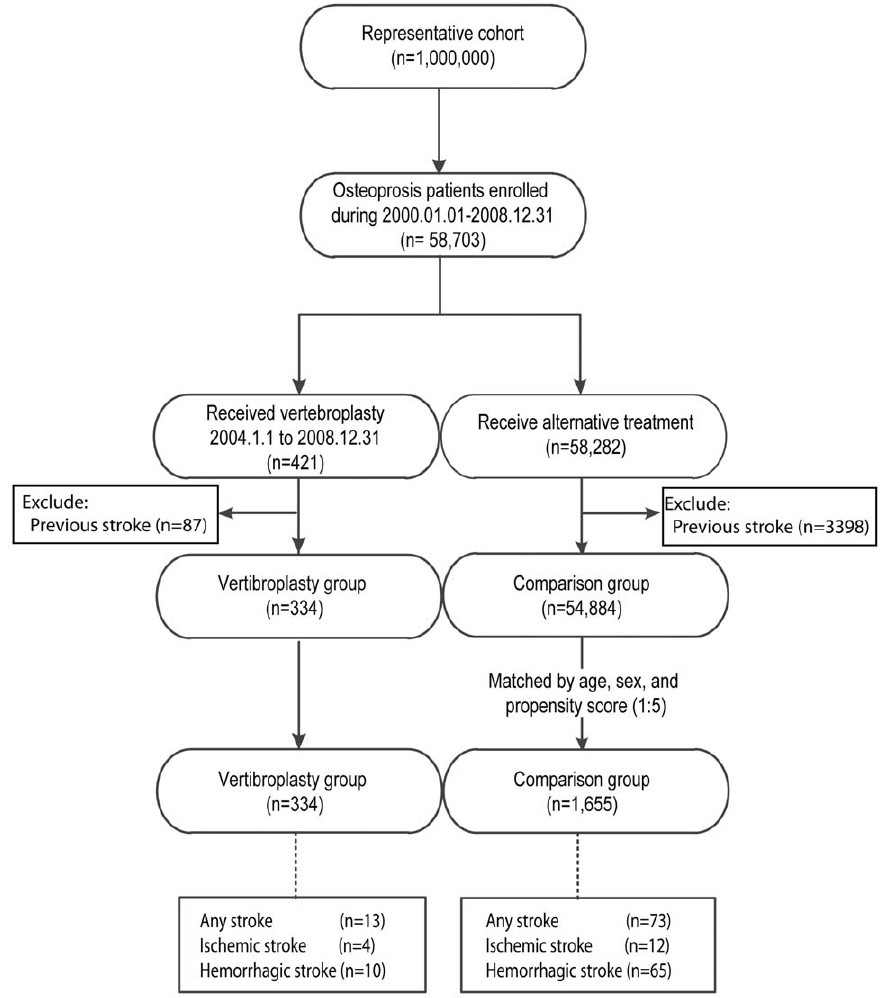
Figure 1. Flow of data processing. From an osteoporotic cohort of 58,703 patients in a nationwide representative cohort of one million people, 421 patients had percutaneous vertebroplasty (vertebroplasty group; n=421), while age-, sex- and propensity score-matched patients comprised the comparison group (n=1,655). The two groups were compared and followed-up for up to five years for subsequent stroke events.